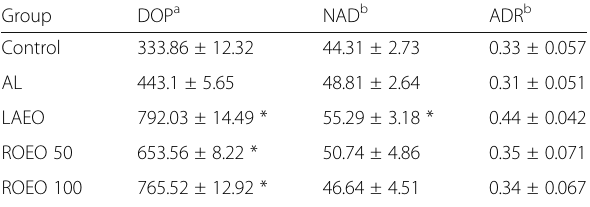
Table 2 Catecholamine, dopamine (DOP), noradrenaline (NAD) and adrenaline (ADR) levels in mice brain (ng/100 mg brain tissue) 1 Group